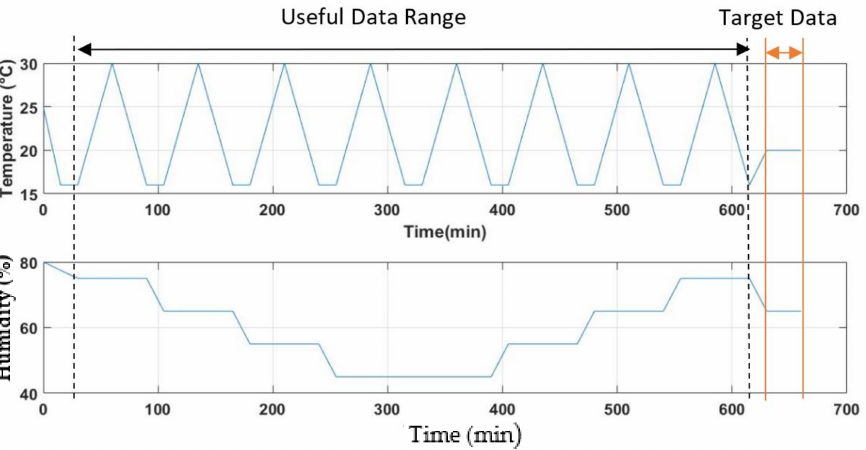
Figure 4. Temperature and humidity control of the incubator: Useful data range and target data range of 30th to 615th and 630th to 660th min,